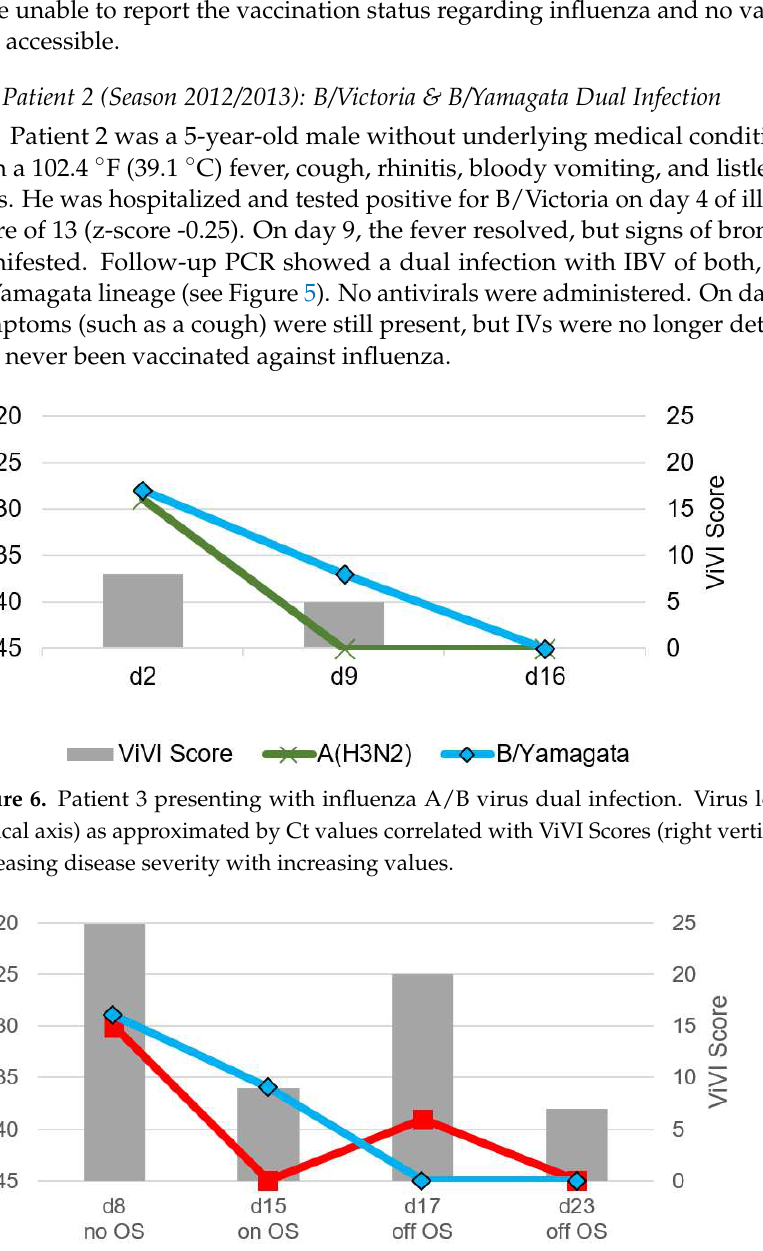
Figure 4. Patient 1 presents with influenza A/A virus dual infection. Virus load (left inverted vertical axis) as approximated by Ct values correlated with ViVI Scores (right vertical axis) reflecting in- creasing disease severity with increasing values.